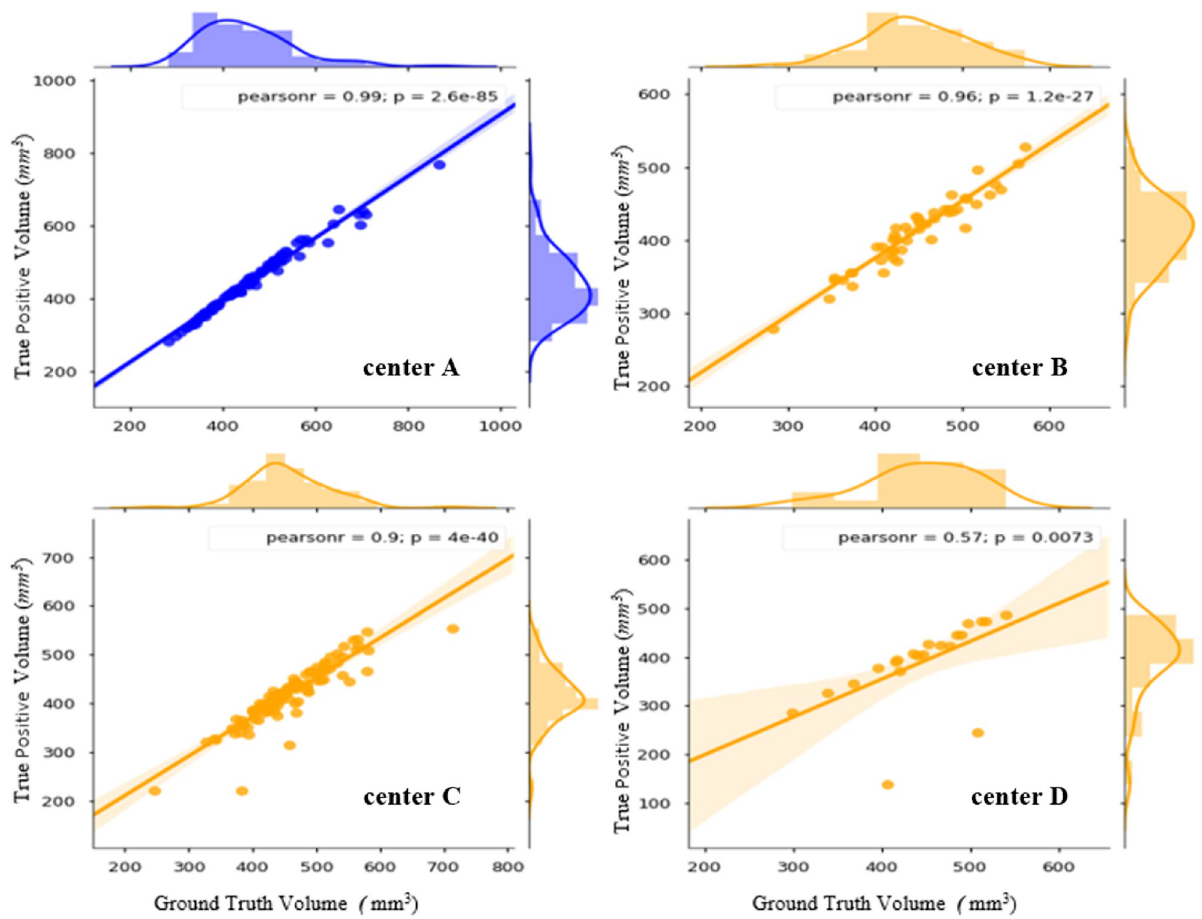
Figure 5. The quantitative analysis showing linear correlations between the ground truth volume and the predicted true positive volume for the validation (plot in blue) and the test sets (plots in orange). The plot of center D shows 2 clear outliers which do not fit the trendline. This suggests under-segmentation of the inner ear in 2 cases belonging to the test cohort from Center D.